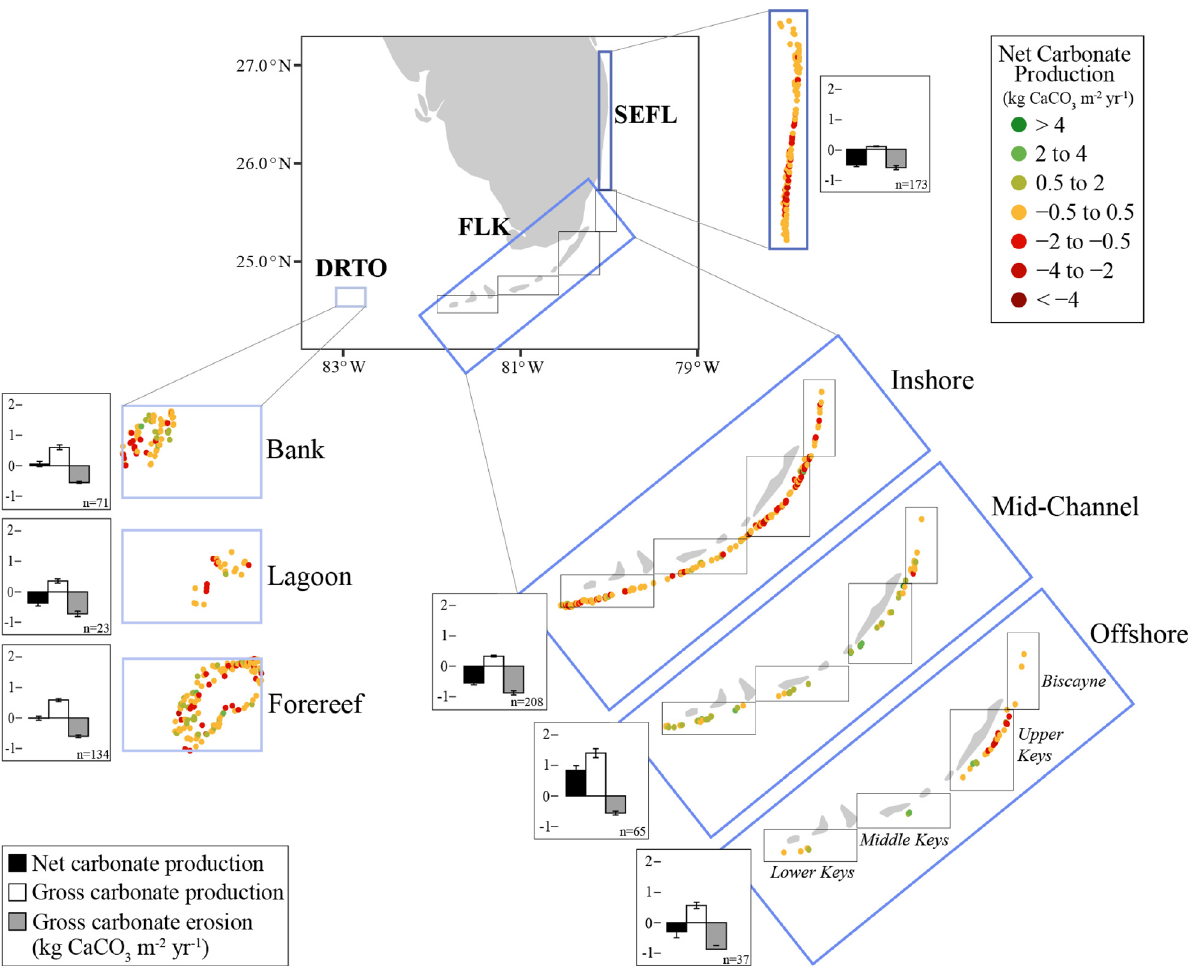
Figure 1. Spatial trends in South Florida reef development. Location of study sites across the FRT with net carbonate production (kg CaCO 3 m −2 year −1 ) represented by the indicated color scheme. The